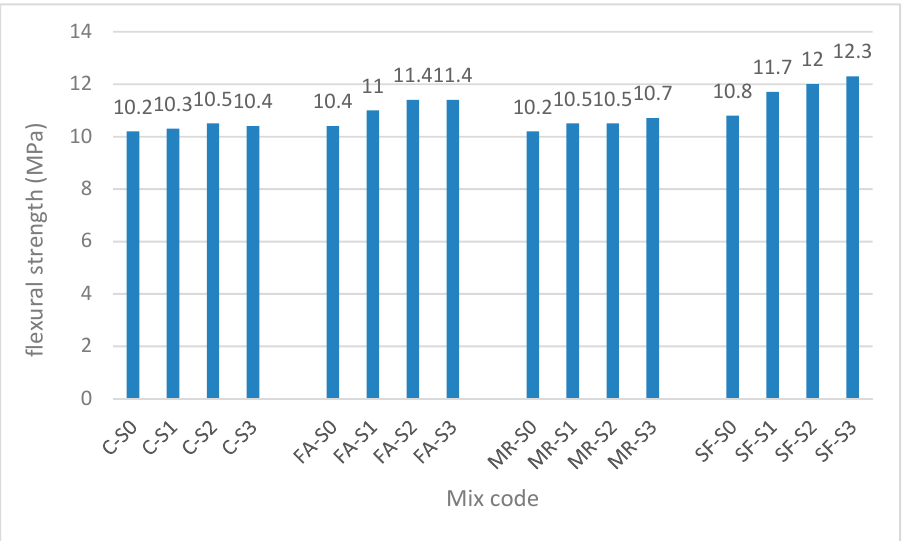
Figure 7. Flexural strength test at 28 days.